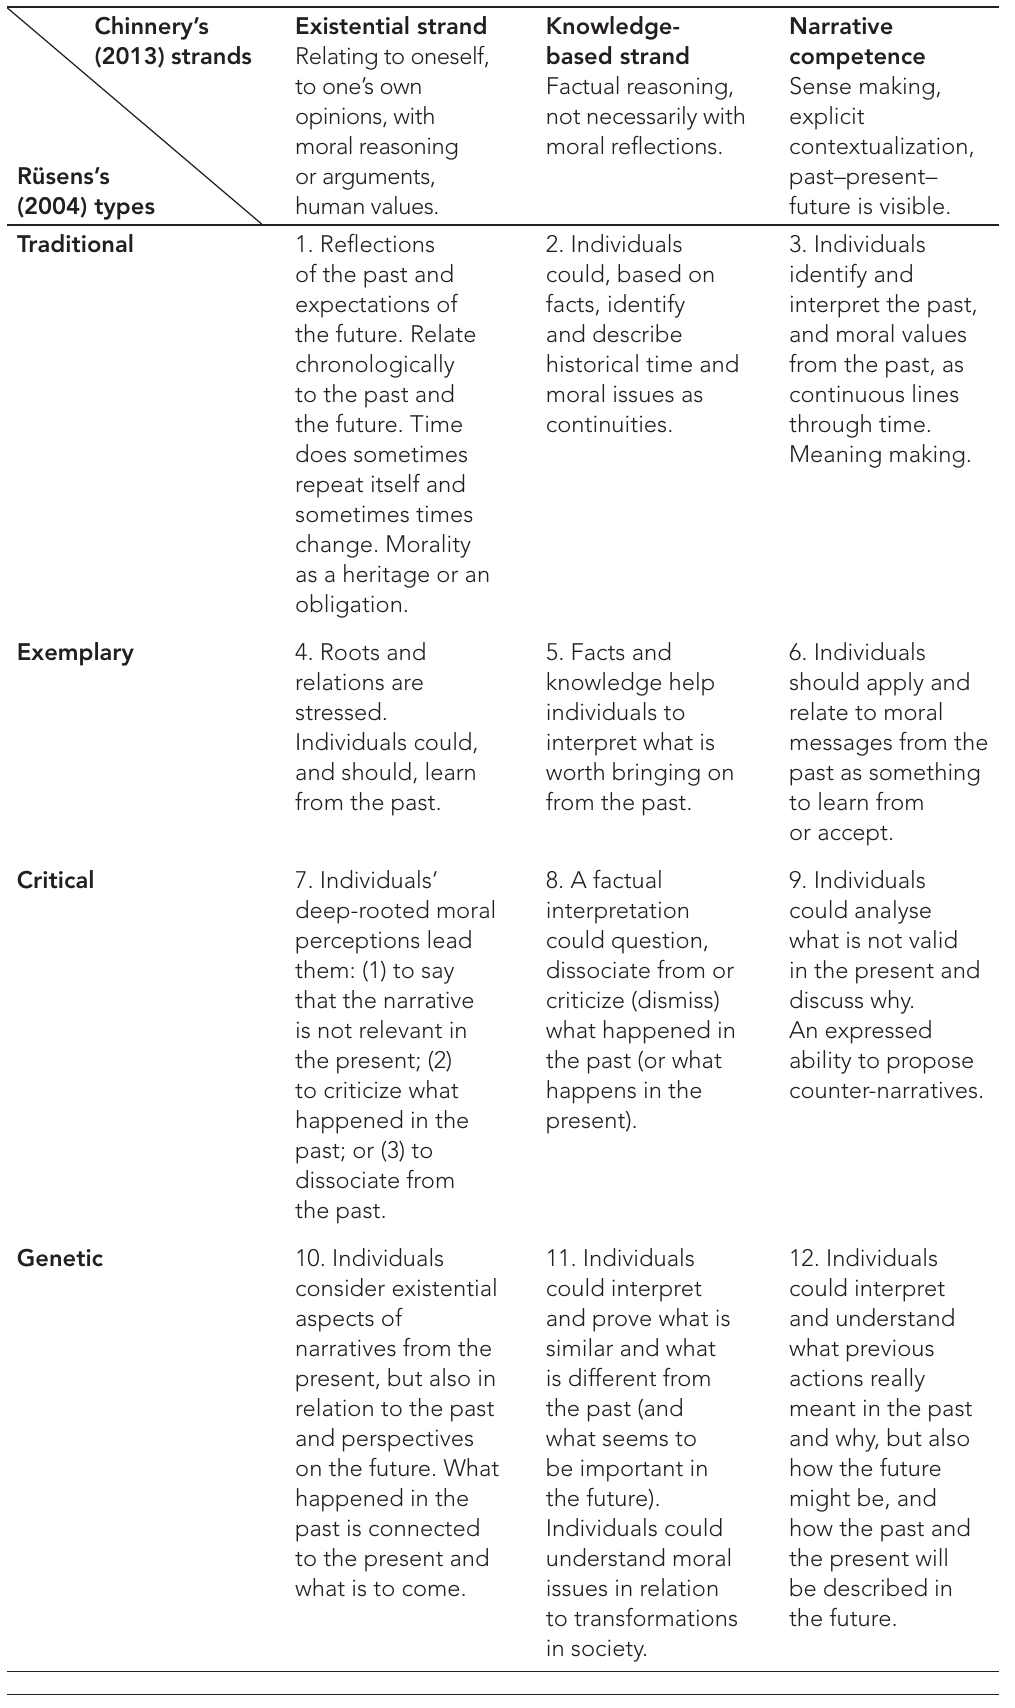
Table 1: Combined theoretical typologies for analysing expressions of temporal orientation in relation to moral